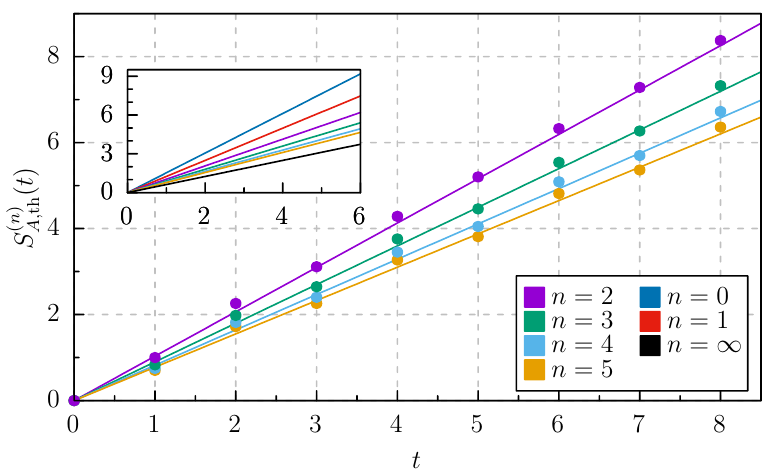
Figure 2: Growth of the Rényi n -entropy after a homogeneous quench from the state ) = ( 0.65,0.15 ) , for typical values of n . Solid lines are the characterised by ( ϑ , ϑ L R asymptotic prediction obtained by neglecting the subleading corrections and taking into account only the largest eigenvalue of the tensor network (52), while the dots correspond to exact finite-time values in the L → ∞